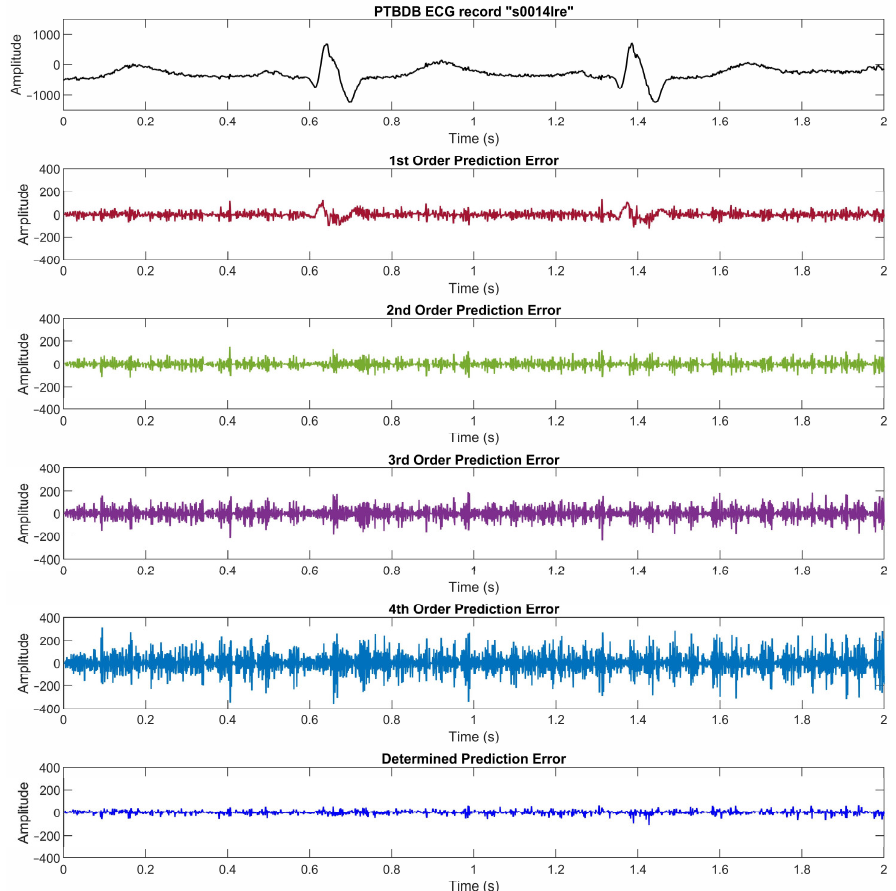
Figure 9. The ECG signal, prediction errors for linear prediction orders 1, 2, 3, and 4, and the determined prediction error of PTBDB record “s0014lre”. To convert the amplitude to millivolts, divide the value by 2000.